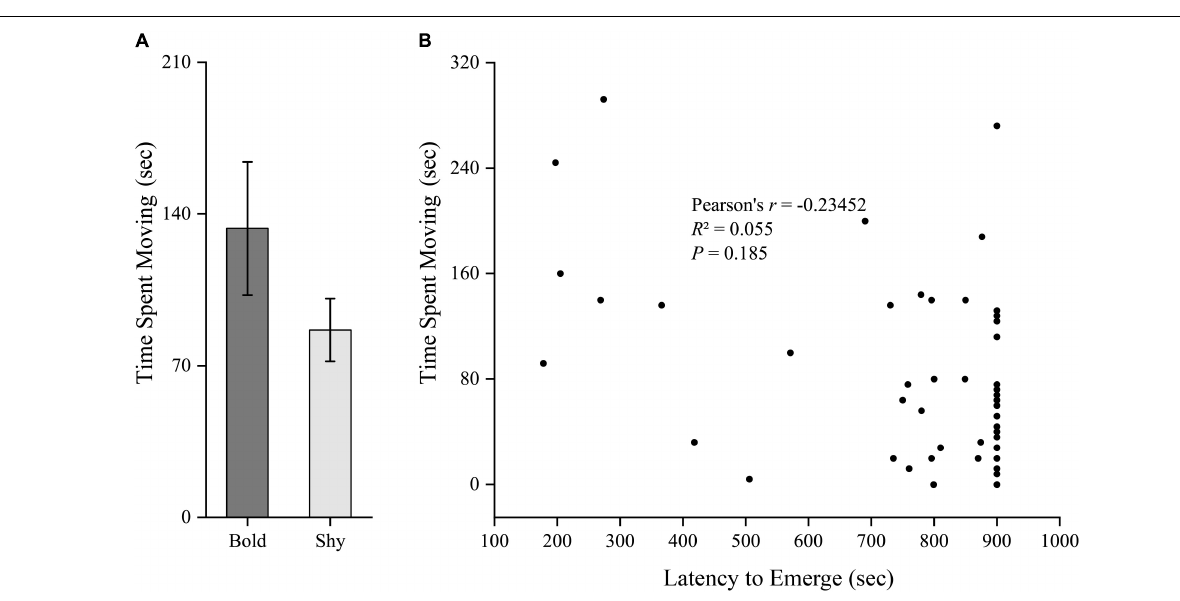
FIGURE 3 | The boldness and basal locomotor activity of black rockfish. (A) The time spent moving (under normal condition) in bold ( n = 9) and shy ( n = 44) groups. ( P > 0.05; independent samples t -test). (B) Pearson’s correlation between the latency to emerge from the start box (box-emerging boldness test) and the time spent moving (under normal condition) ( n =